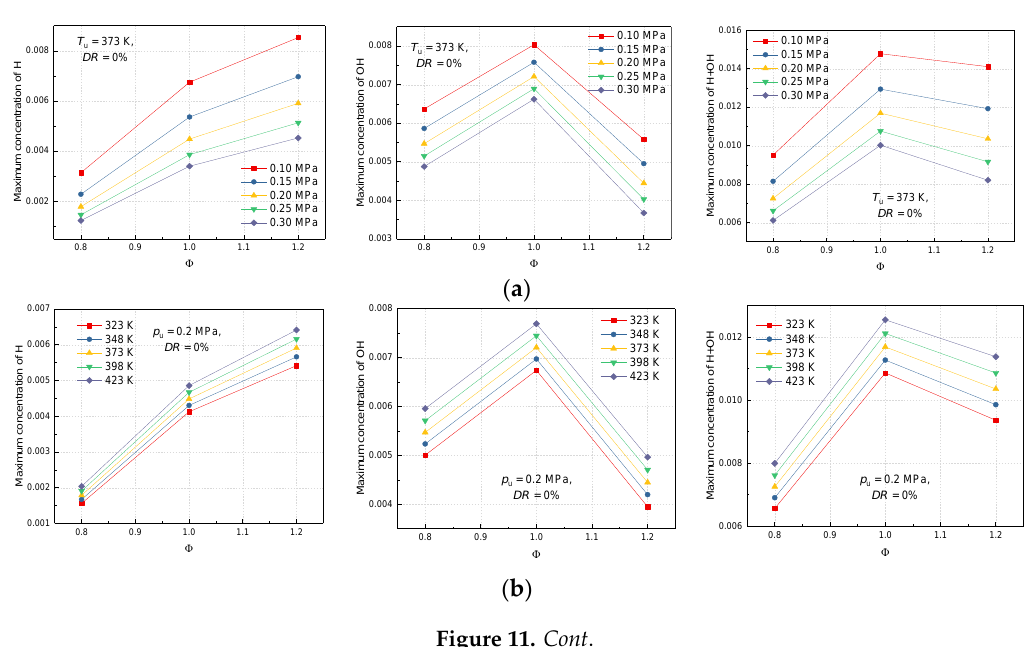
Figure 10. Flame structures under different dilution rates. ( a ) DR = 0%, Φ = 1.0; ( b ) DR = 4%, Φ = 1.0; ( c ) DR = 8%, Φ = 1.0; ( d ) DR = 12%, Φ = 1.0.